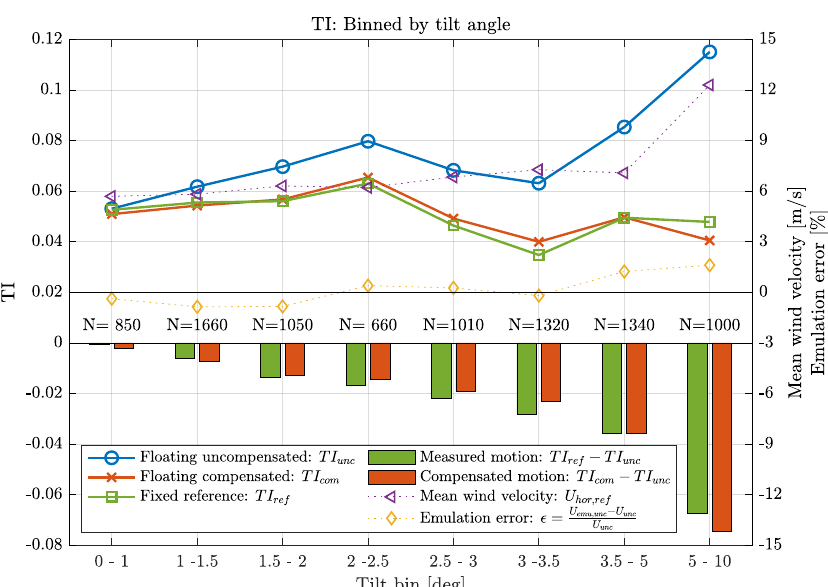
Figure 10. TI from all measurement heights binned by α , the mean tilt angle of the buoy. Legend as in Figure 8 plus markers for the horizontal mean wind velocity U and the relative emulation error (cid:101) that refer to the right hand side y